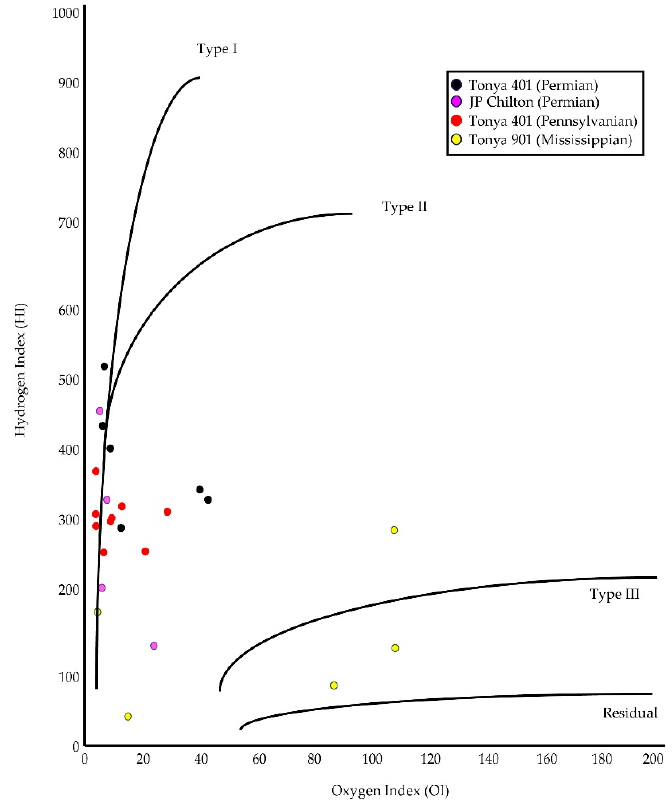
Figure 9. Pseudo-van Krevelen diagram modified from Espitalié et al., 1986 [87].